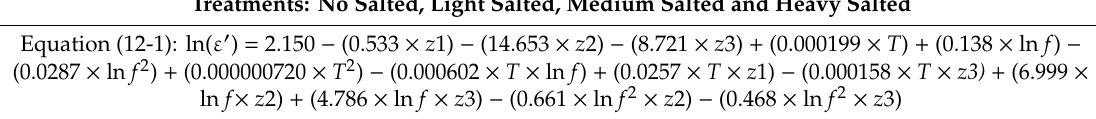
Table 12. Study of the e ff ect of four categories on the dielectric properties of pecan nut using regression